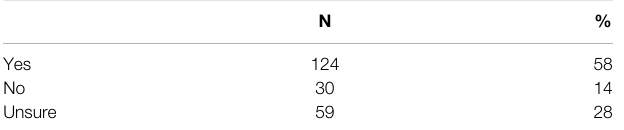
TABLE 4 | Capability of being a space professional. This table demonstrates how participants responded to the question “ Do you feel capable of being a space professional if you wanted to? ” This result was analysed to check if any signi fi cant statistical relationships existed between demographic categories, but no differencesortrendswere identi fi ed onthe basisofgender (DF (cid:1) 2, χ 2 (cid:1) 0.87, ρ (cid:1) 0.65), education (DF (cid:1) 8, χ 2 (cid:1) 0.24, ρ (cid:1) 1.0), or current status